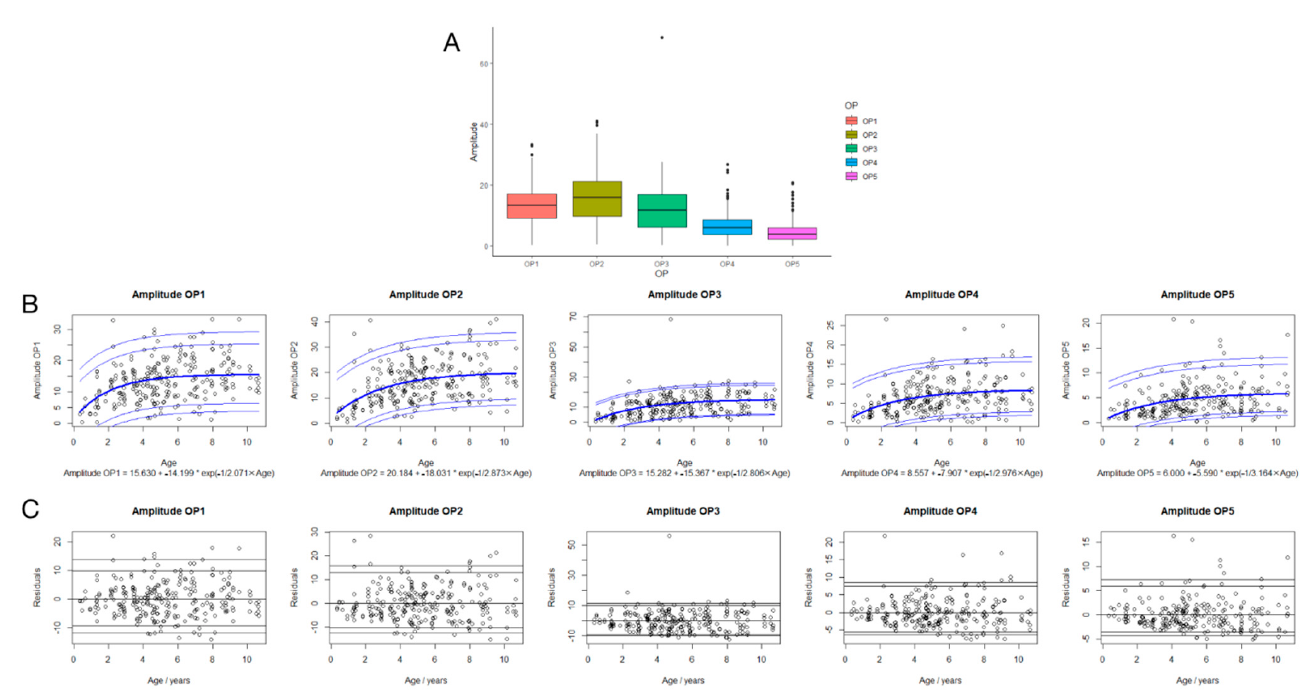
Figure 3. The amplitudes of OPs dependence on age. The density plot for the amplitudes of OP1-5 ( A ). OPs amplitudes ( B ) are shown versus age. The fitted equation for the bold curve (labeled as the 50th percentile) is shown at the bottom of the plot. Other percentiles with additional offsets are shown with thin blue lines. Fit residuals of regression ERG dependence on age ( C ). Fit residuals, or the difference between the measured value and the fitted equation, are displayed as amplitudes. Each patient has one symbol per eye.